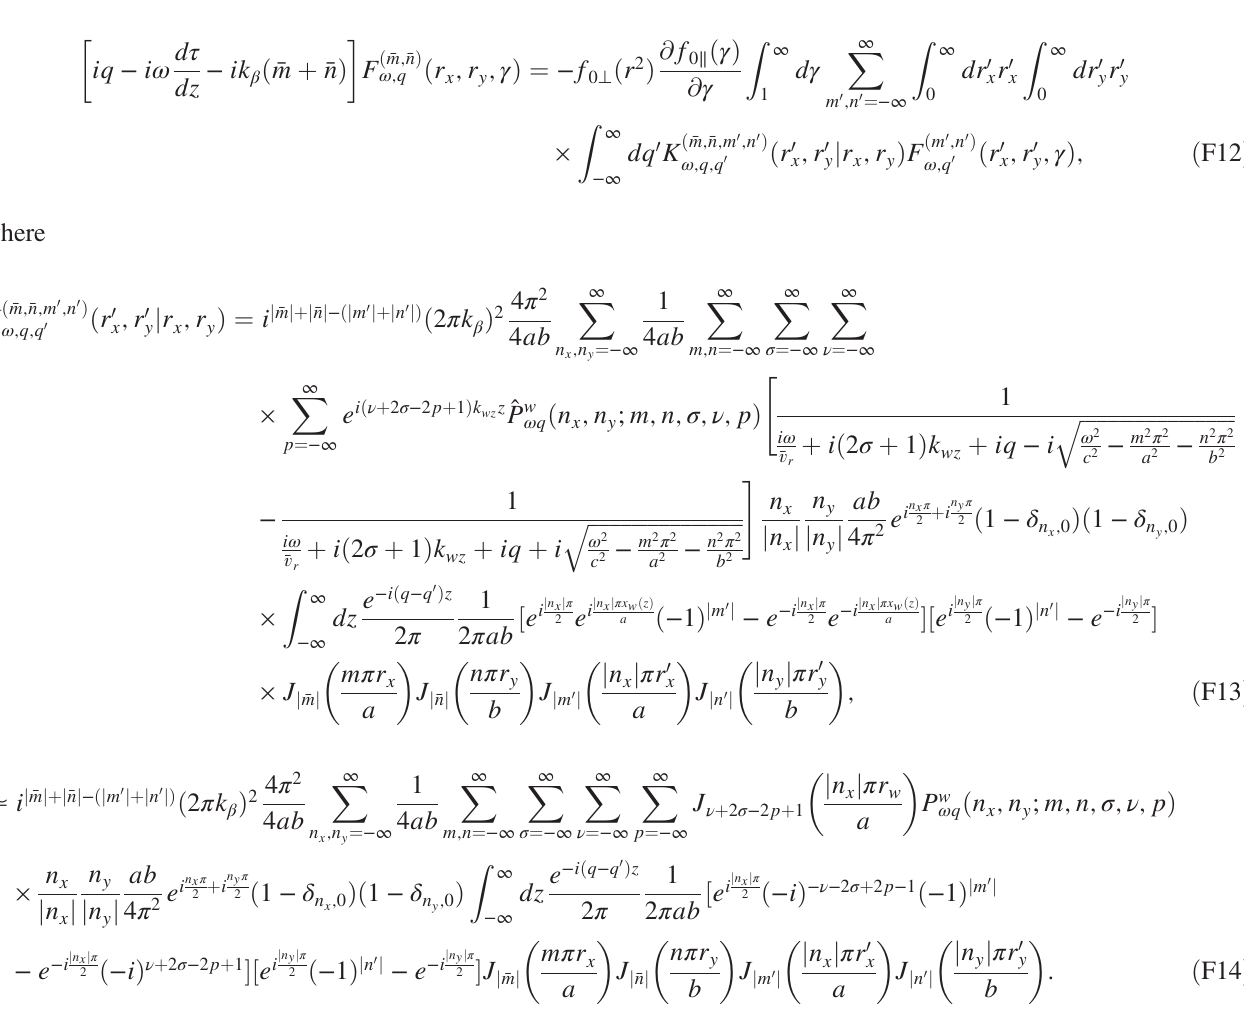
ffiffiffiffiffiffiffiffiffiffiffiffiffiffiffiffiffiffiffiffiffiffiffiffiffiffiffiffiffi